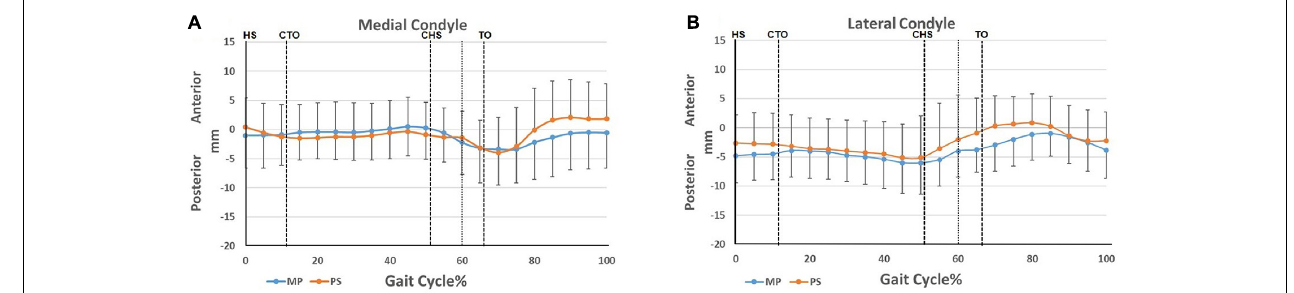
FIGURE 4 | Condylar motion of the medial and lateral condyles relative to the tibia. (A) Anterior/posterior translation of the medial femoral condyles of the MP and PS TKA; (B) anterior/posterior translation of the lateral femoral condyles of the MP and PS TKA. Blue lines: MP TKA. Red lines: PS TKA. The means and standard deviations of translations were represented by solid lines and short vertical bars. The dashed lines at 60% cut the gait cycle into stance phase and swing phase. Gait events include: HS, heel-strike; CTO, contralateral toe-off; CHS, contralateral heel-strike; TO,